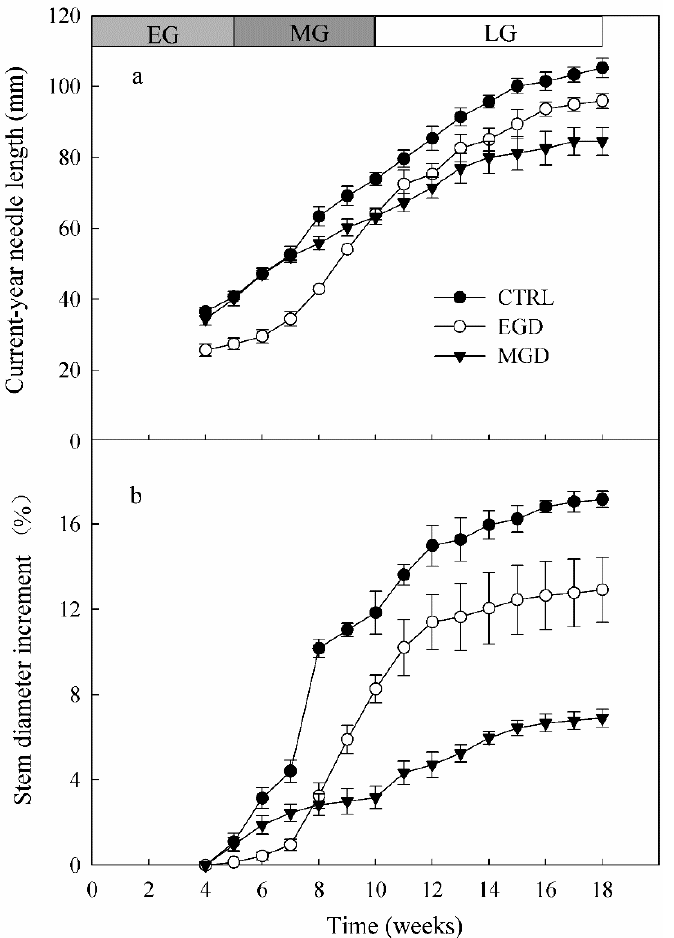
Figure 7. Mean current-year needle length ( a ) and basal stem diameter increment ( b ) of Mongolian pine saplings by treatment. CTRL indicates the control. EGD and MGD indicate drought stress treatment in the early- (EG) and mid- (MG) growing seasons, respectively. EG, MG and LG refer to the early- (weeks 1–5), mid- (weeks 6–10) and late- (weeks 11–18) growing season, respectively. Time indicates weeks from the beginning of the experiment. Bars indicate standard error ( n = 4).